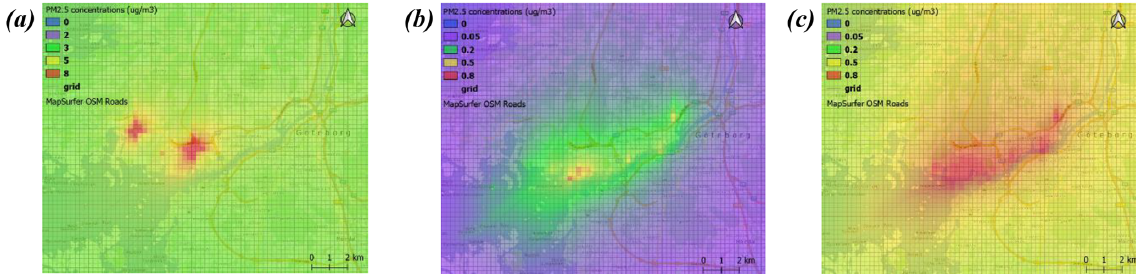
Figure 10. Modelled annual mean PM 2 . 5 concentrations (µgm − 3 ) and contributions of shipping in the year 2012: (a) modelled annual mean concentrations in the base model simulation, (b) modelled annual mean contribution of local shipping and (c) modelled annual mean contributions of local and regional shipping. Base map credits: © OpenStreetMap contributors 2020. Distributed under a Creative Commons BY-SA License.